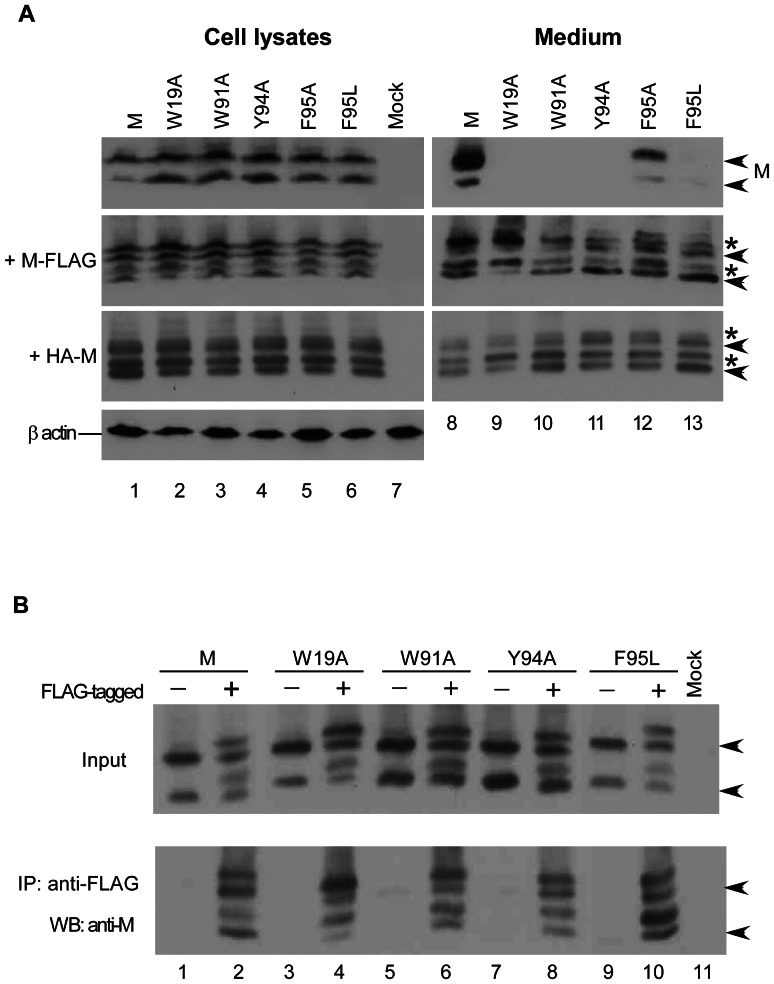
Effects of substitution mutations on M-M interaction.(A) Associations between mutant M proteins and FLAG-tagged or HA-tagged wt M. 293T cells were transfected with the indicated plasmid alone (upper panels) or with a FLAG-tagged (M-FLAG) or HA-tagged (HA-M) SARS-CoV M expression vector. At 24–36 h post-transfection, cells and medium were harvested and subjected to Western immunoblot analyses as described in the Figure 2 caption. Arrowheads and asterisks denote M and FLAG-tagged M positions, respectively. (B) Co-immunoprecipitation of M with FLAG-tagged M. 293T cells were transfected with the SCoV M wt or indicated mutant plasmid alone or with its FLAG-tagged counterpart (lanes 2, 4, 6, 8 and 10). Cell lysates were subjected to Western immunoblotting 48 h post-transfection. Equal amounts of cell lysates were mixed with anti-FLAG affinity gel and incubated for 2 h at 4°C. Bead-bound complexes were pelleted, washed, and subjected to Western immunoblotting.